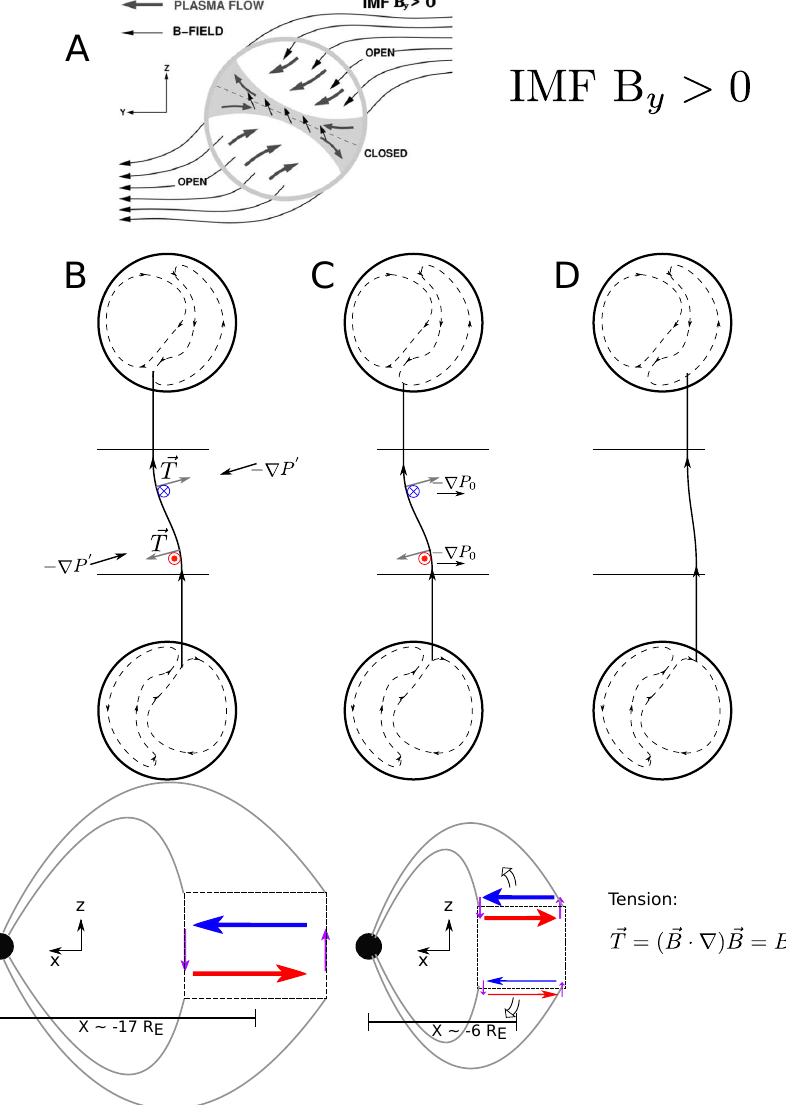
Figure 12. (a) Asymmetric entry of magnetic flux in the lobes during positive IMF B y conditions (Fig. 3a from Liou and Newell, 2010). (b– d) Evolution of a flux tube on closed field lines with asymmetric foot points in the dawn convection cell during IMF B y positive conditions. Upper panels show pressure, tension and asymmetric foot points into the dawn cells. Lower panels show the associated current systems seen from dusk. (b) In the mid-tail region the asymmetric pressure forces due to IMF B y and the magnetic tension forces on the flux tube are balanced. Currents close locally as indicated in the lower panel. (c) At a later stage the flux tube moves earthward and is affected by the (total) pressure gradients surrounding the Earth (plasma and magnetic field). Now the forces do not balance. In the Northern Hemisphere these forces point in the same direction. Hence, most of the stress is transmitted into this hemisphere and the northern foot point will catch up with the southern counterpart to restore symmetry, as seen in (d)